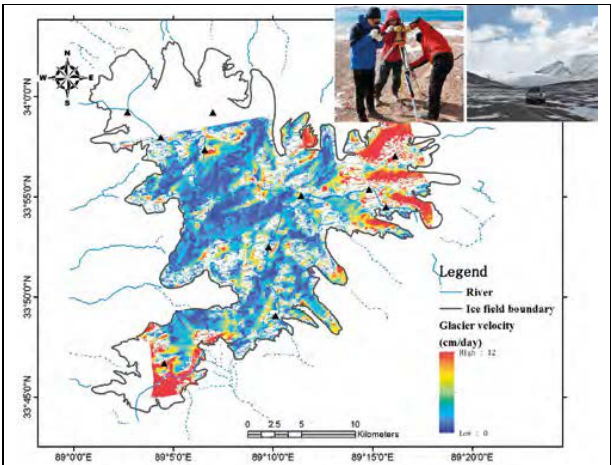
Figure 9. Glacier surface velocity and Field work (up right) in